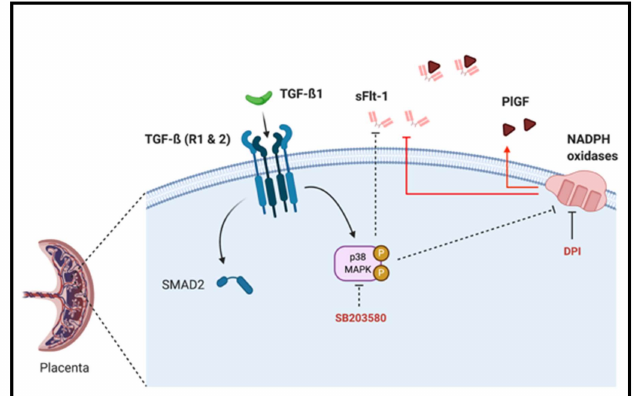
Figure 6. Schematic representation of TGF- β 1/Nox/p38 MAPK mediated sFlt-1 secretion in first